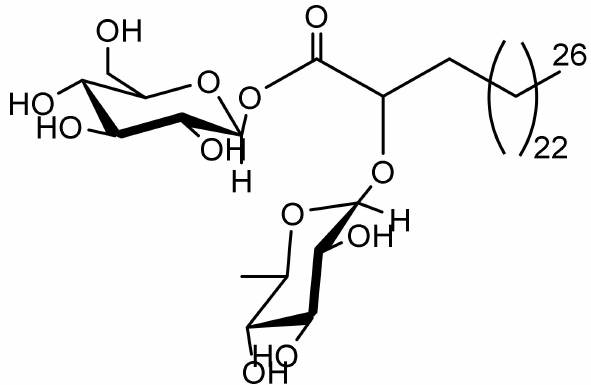
Figure 1. Chemical structure of the new FAG [2-O- α -L-rhamnopyranosyl-hexacosanoate- β -D- glucopyranosyl ester] isolated from the ethyl acetate extract of Ficus benghalensis fresh